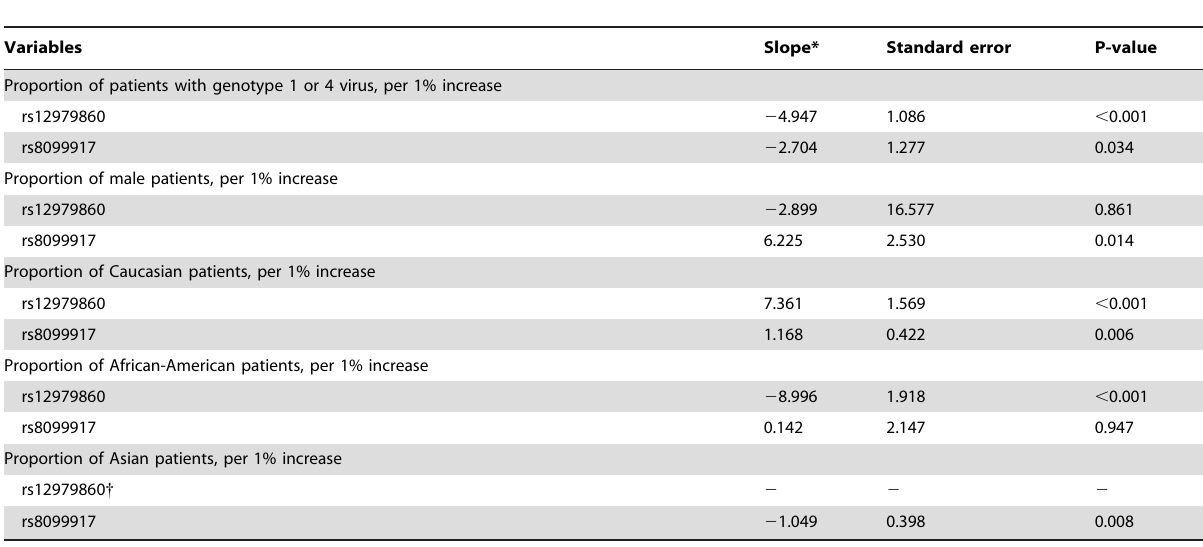
Table 3. Meta-regression analysis between each continuous variable among the studies and the effect (log odds ratio) of IL28B polymorphisms on